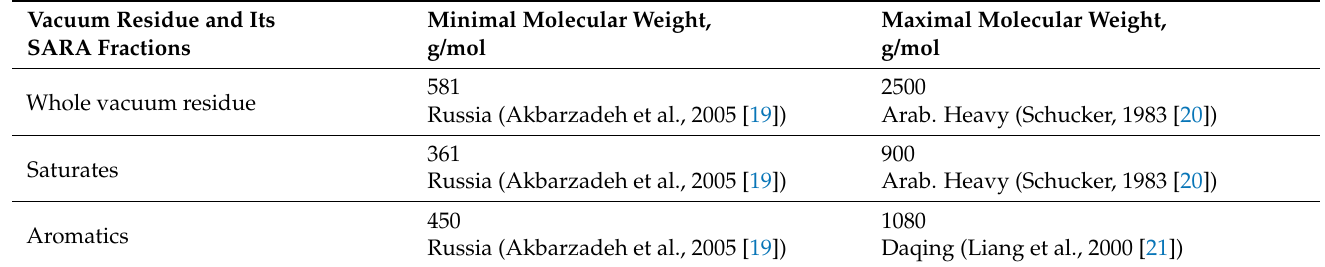
Table 1. Variation in molecular weights of VR and its SARA fractions reported in